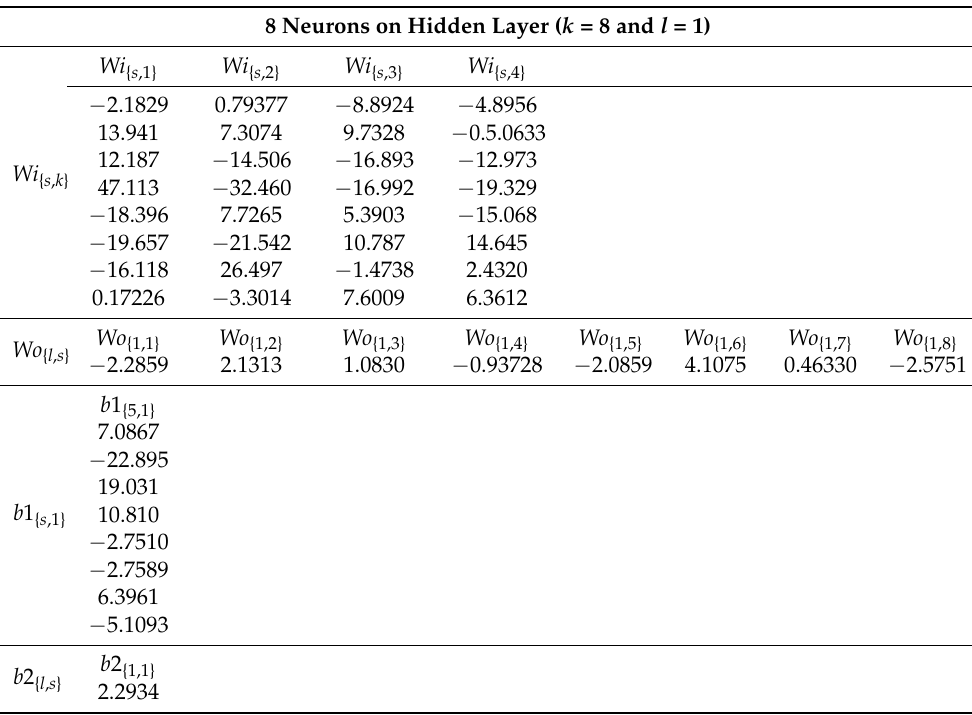
Table A2. Weights and biases for the ANN model predicting leptin concentration.